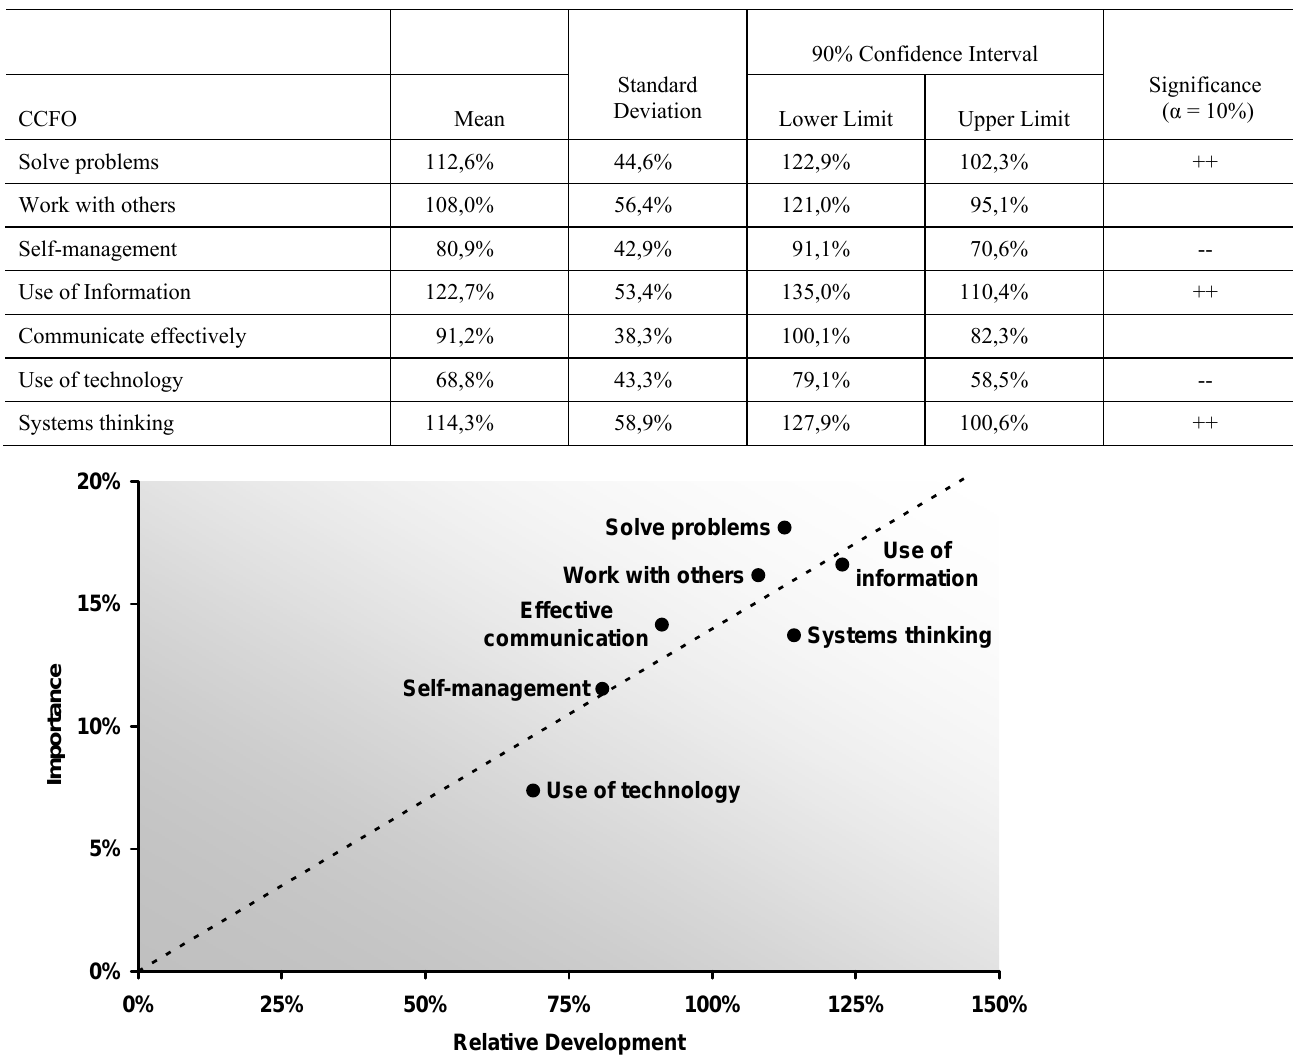
Figure 1: A plot of the assessable critical cross-field outcomes; importance versus development during an